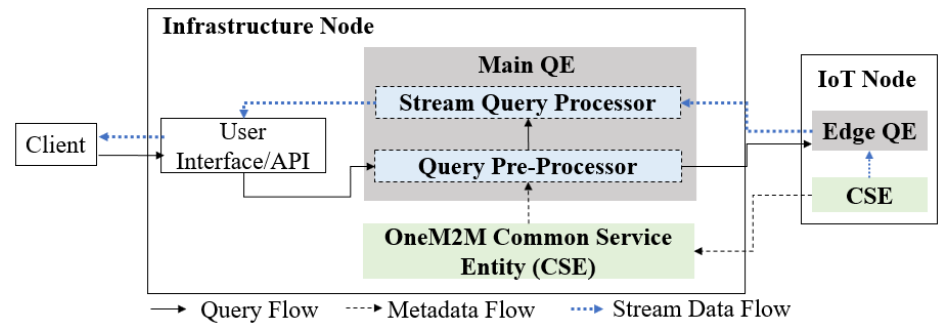
Figure 7. oneM2M QE architecture.